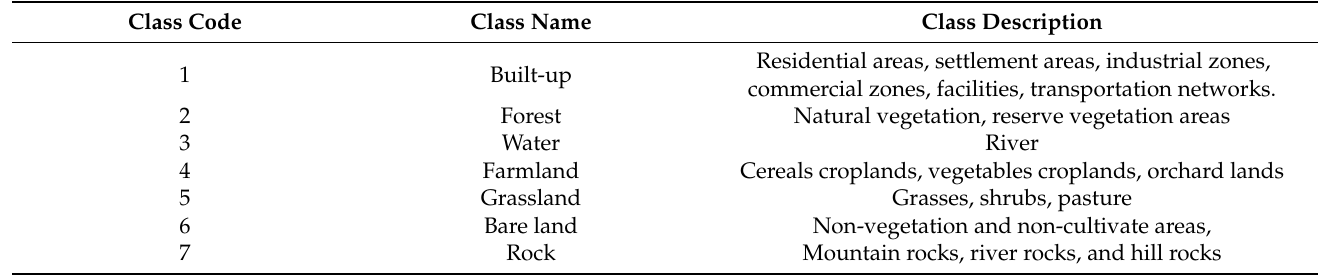
Table 2. Classification class descriptions.